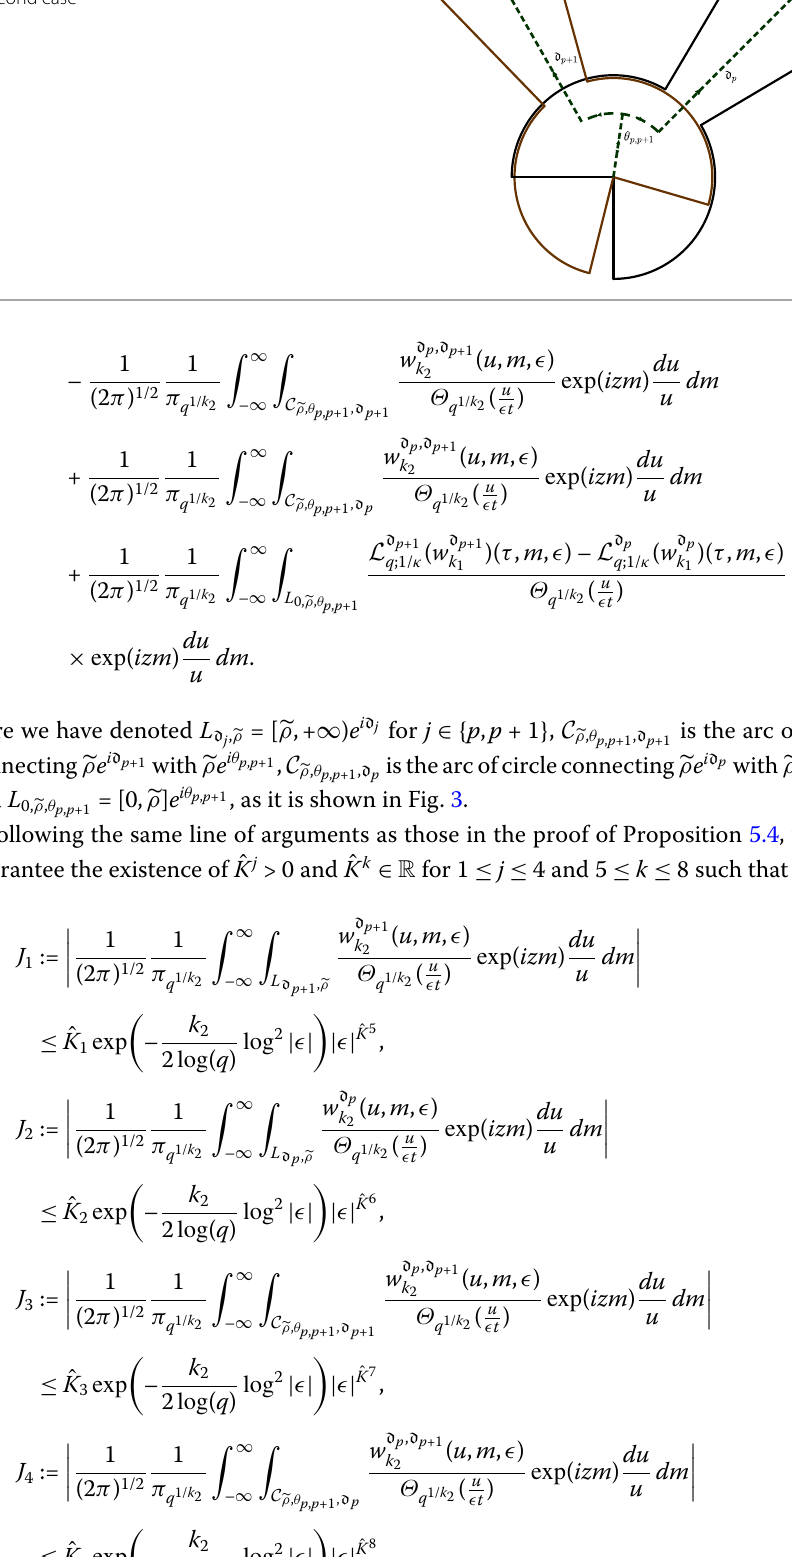
Figure 3 Deformation of the path of integration, second